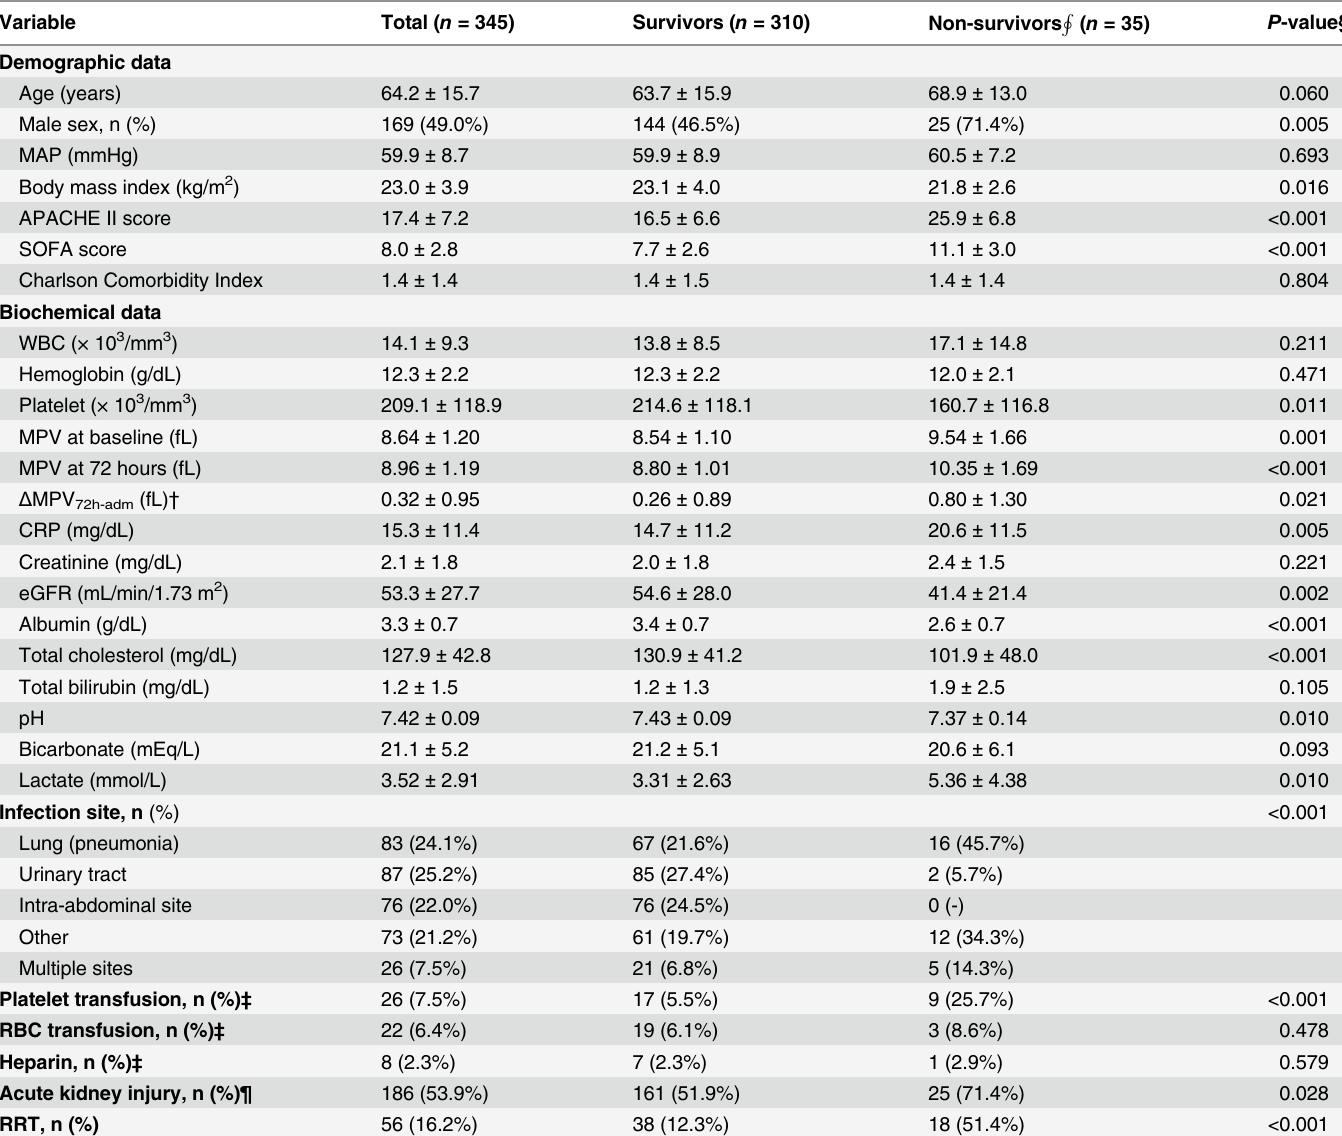
Table 1. Baseline clinical characteristics and biochemical variables according to the occurrence of 28-day all-cause